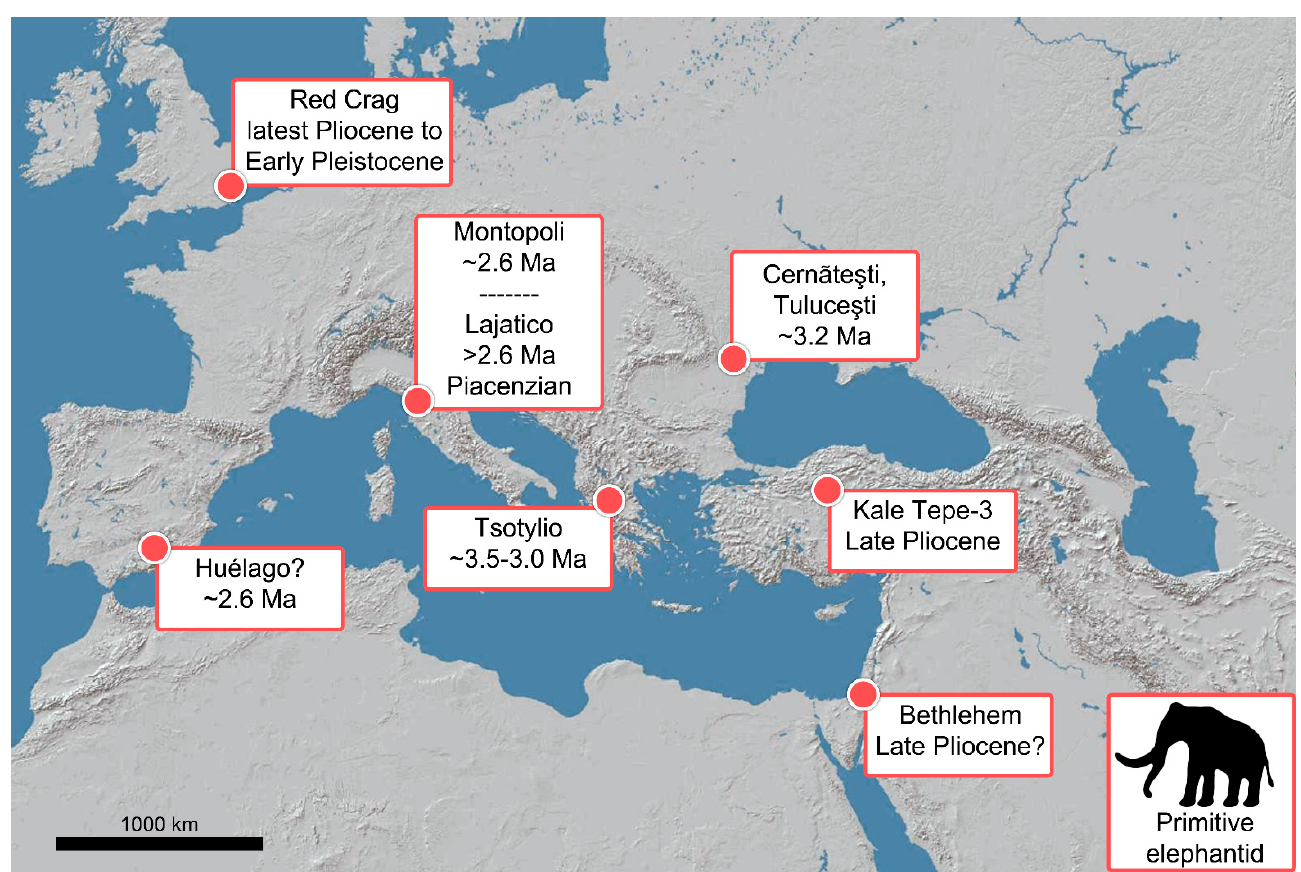
Figure 1. Selected localities mentioned in the text showing the occurrence of primitive elephantid in western Eurasia.